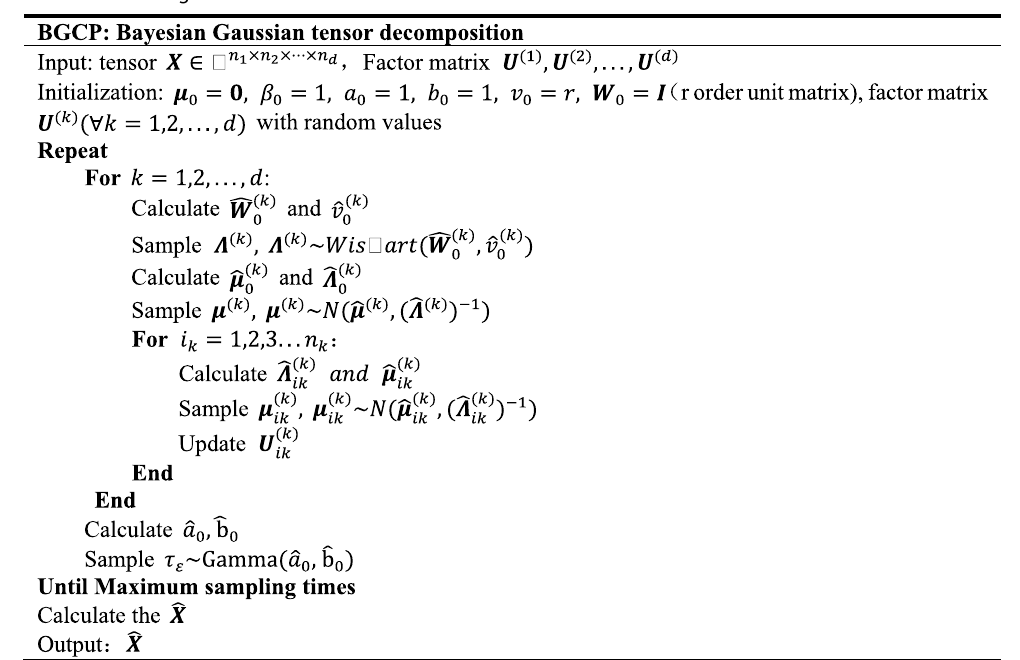
Table 2 Pseudo code of BGCP